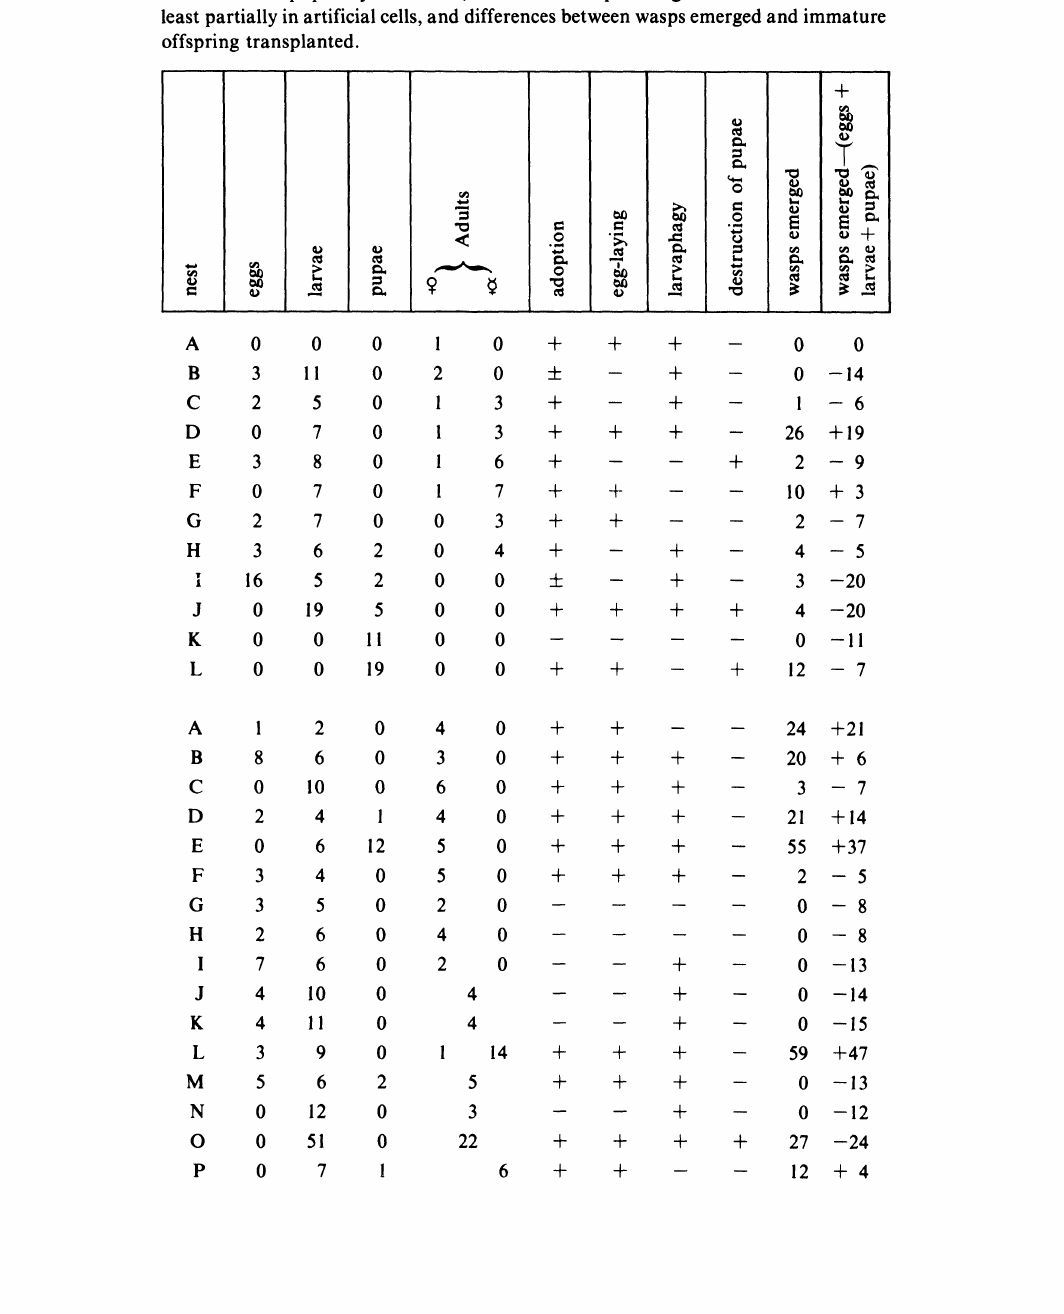
Table I. Flat nests (first and second type) with removable cells. Shown are the number and type of immature offspring transplanted, number of adults on the nest, nest acceptance (+ adoption, + partial adoption,- refusal)egg-laying, larvaphagy, destruction of pupae by the adults, number of wasps emerged from larvae raised at least partially in artificial cells, and differences between wasps emerged and immature offspring